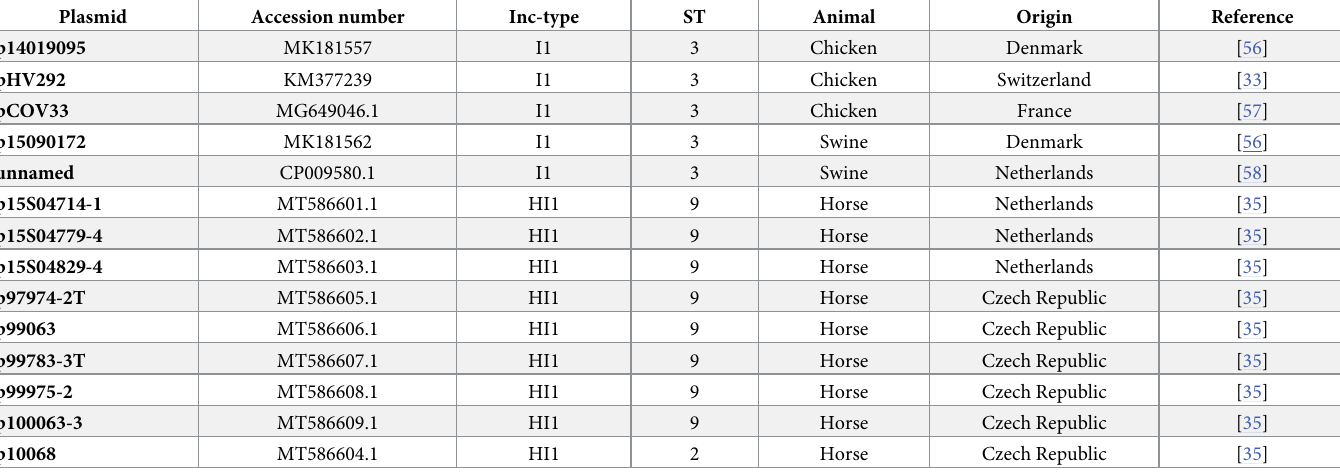
Table 2. Publicly available plasmid sequences retrieved through NCBI BLASTN for phylogenetic comparison with plasmids recovered in this study.